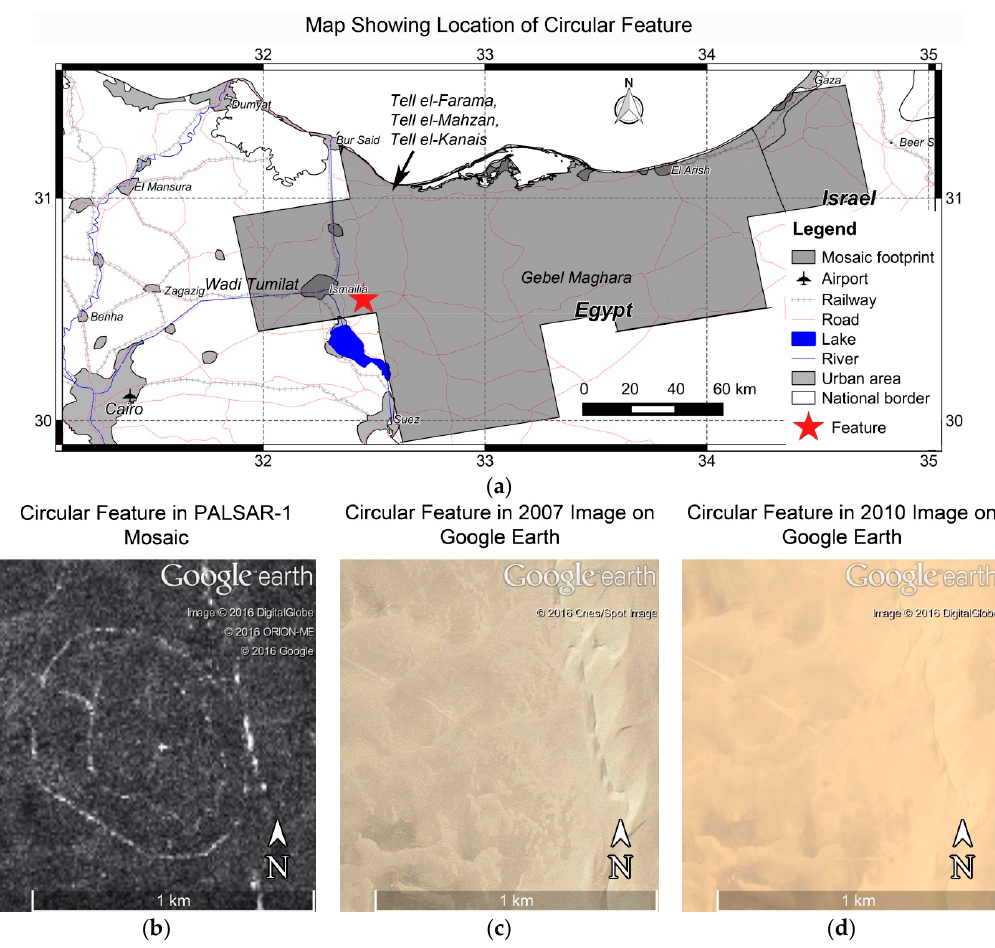
Figure 6. ( a ) Map showing location of one of the circular features (as red star) in the context of the PALSAR-1 mosaic (grey filled polygon); ( b ) circular feature identified in PALSAR-1 mosaic of Average De Grandi filtered PALSAR-1 σ ° backscatter. Feature is centred at 30.544° latitude and 32.452° longitude. PALSAR-1 data provided by ESA. ( c ) Optical image available on Google Earth acquired on 7 February 2007 and covering same extent as ( b ); ( d ) optical image available on Google Earth acquired on 5 May 2010 and covering same extent as ( b ).